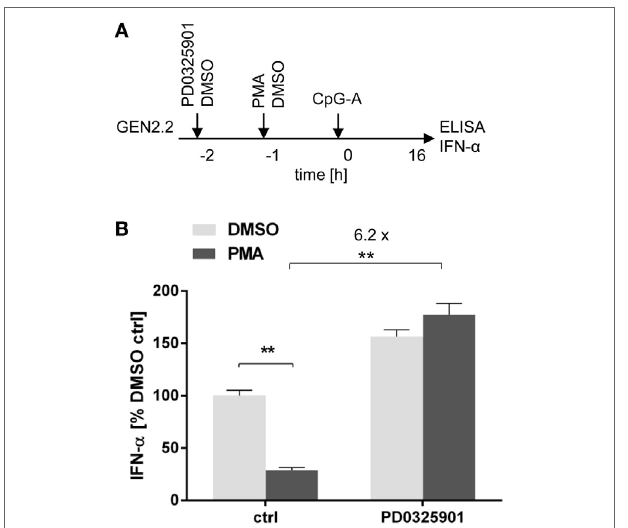
FigUre 6 | Effect of MEK1/2 inhibitor PD0325901 on the blockade of IFN- α production in phorbol myristoyl acetate (PMA)-stimulated GEN2.2 cells. (a) Experimental outline. GEN2.2 cells separated from MS-5 feeder cells were incubated with the MEK1/2 inhibitor for 1 h before stimulation with PMA. After a 16 h culture, the IFN- α production was determined in the cell-free supernatants by ELISA. (B) The IFN- α production was normalized to the level induced by CpG-A in the presence of DMSO and in the absence of the MEK1/2 inhibitor. The data show mean ± SEM of six independent experiments with GEN2.2 cells. **, p < 0.01; two-tailed Mann–Whitney test.